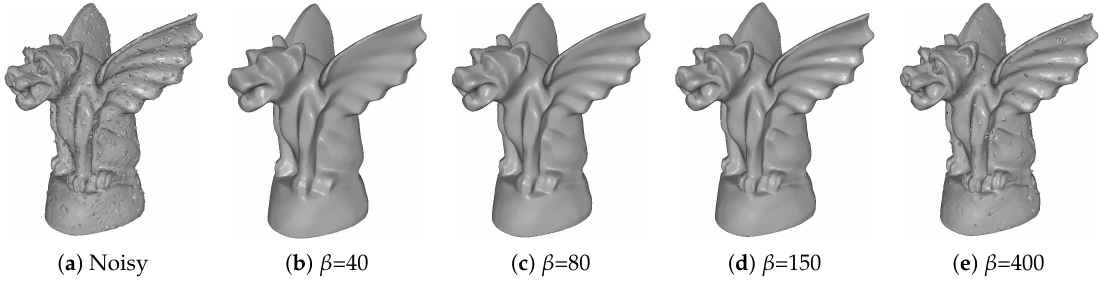
Figure 2. Denoising results for different β with fixed other parameters ( α , γ , and δ ). From left to right: input noisy mesh (corrupted by Gaussian noise with standard deviation σ = 0.1 mean edge length and 15% of impulsive noise with standard deviation σ = 0.6 mean edge length) and results with different β .